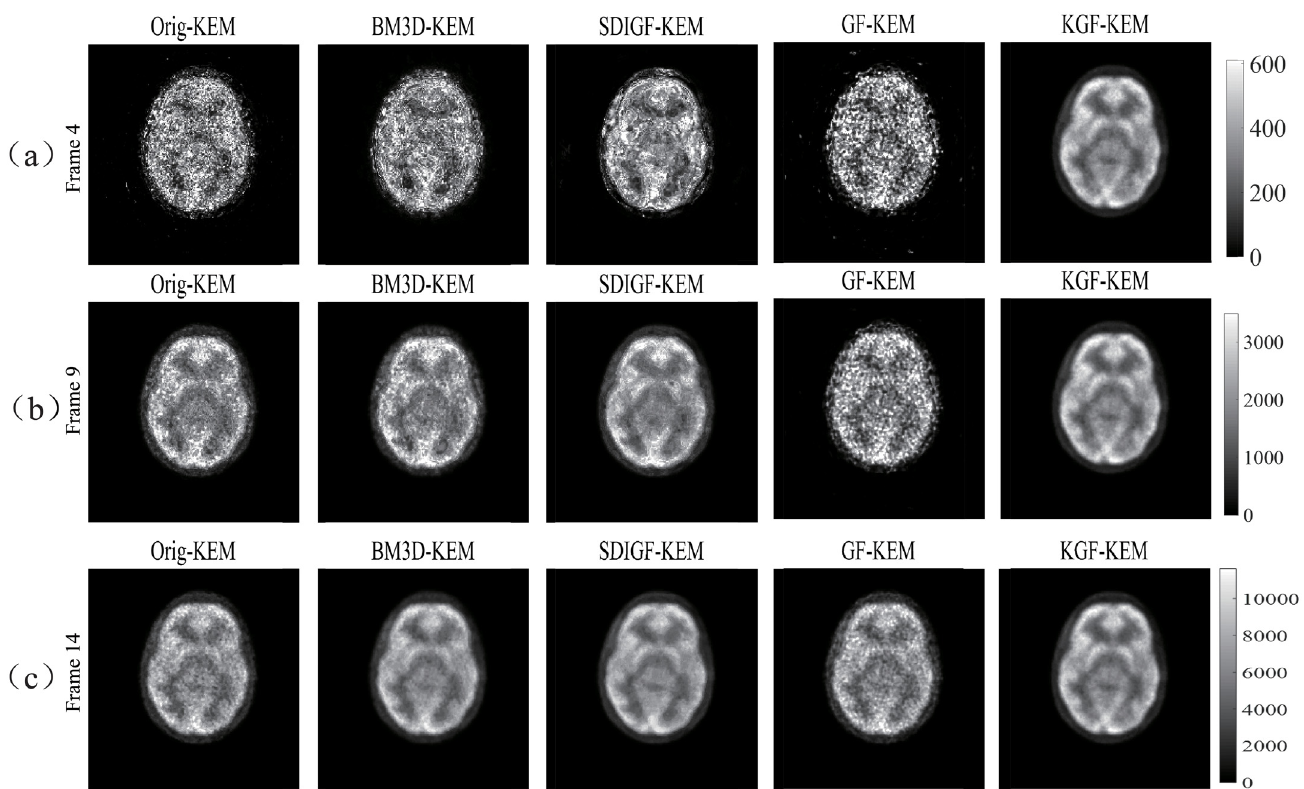
Fig 13. KEM reconstructed images from the in-vivo sinogram datasets shown in Fig 11. Column Orig: original dataset, other columns: datasets denoised by respective methods.